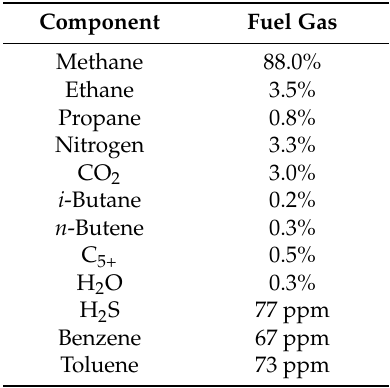
Table 1. Composition of gathered flare gas